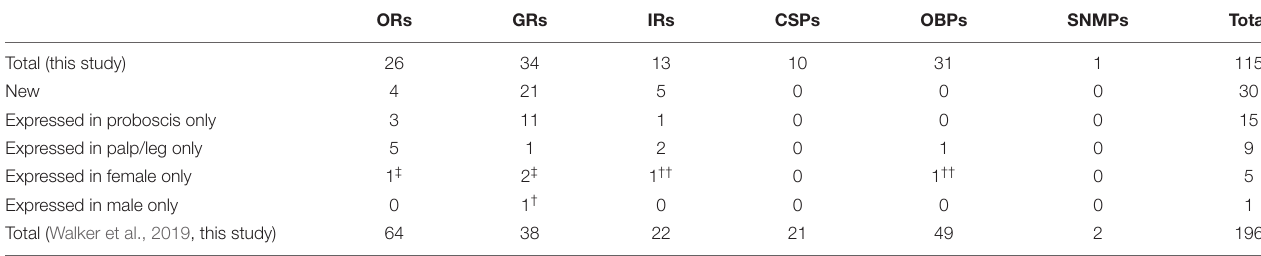
TABLE 1 | Summary of S. littoralis chemosensory genes identified in this study. ORs GRs IRs